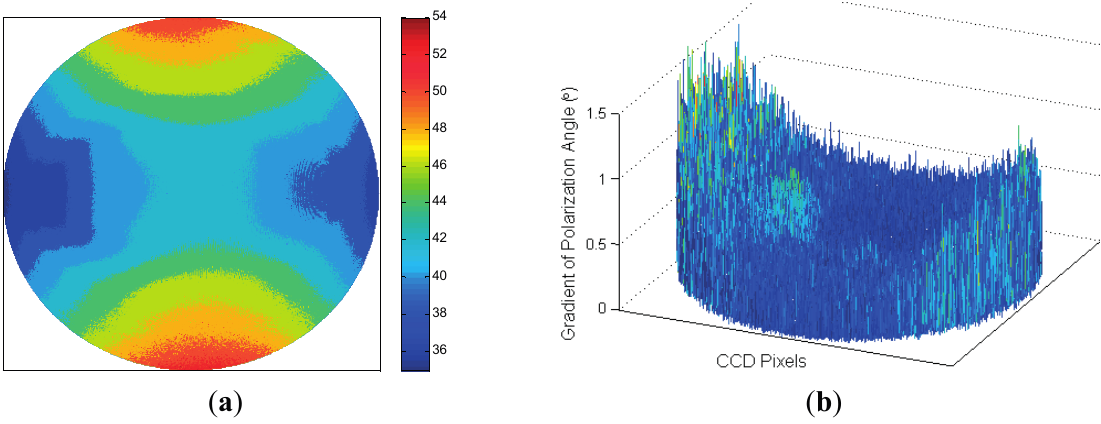
Figure 6. ( a ) Contour plot of measured polarization patterns of the display; ( b ) Gradient of polarization angle at every effective Charge Coupled Device (CCD)